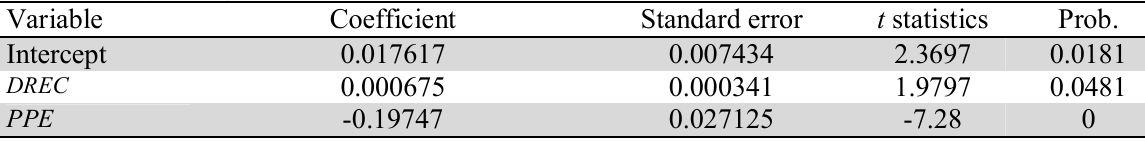
The summary of regression analysis